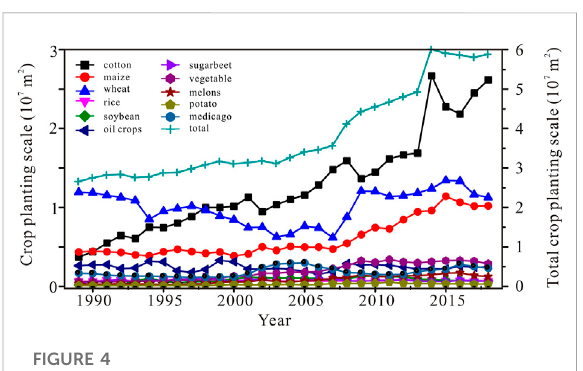
FIGURE 3 Different trends in crop water use in Xinjiang from 1989 to 2018.